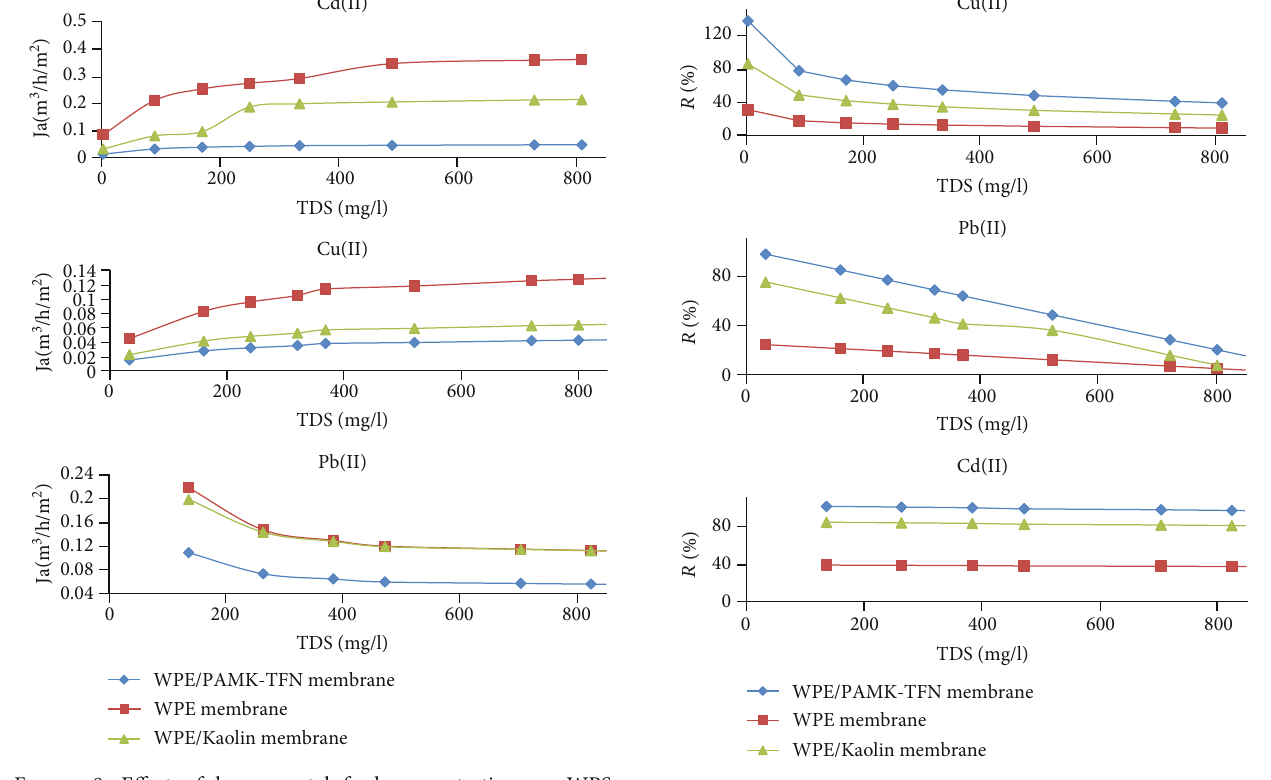
Figure 9: E ff ect of heavy metal feed concentration on WPS, WPS/kaolin, and WPE/PAMK-TFN membrane